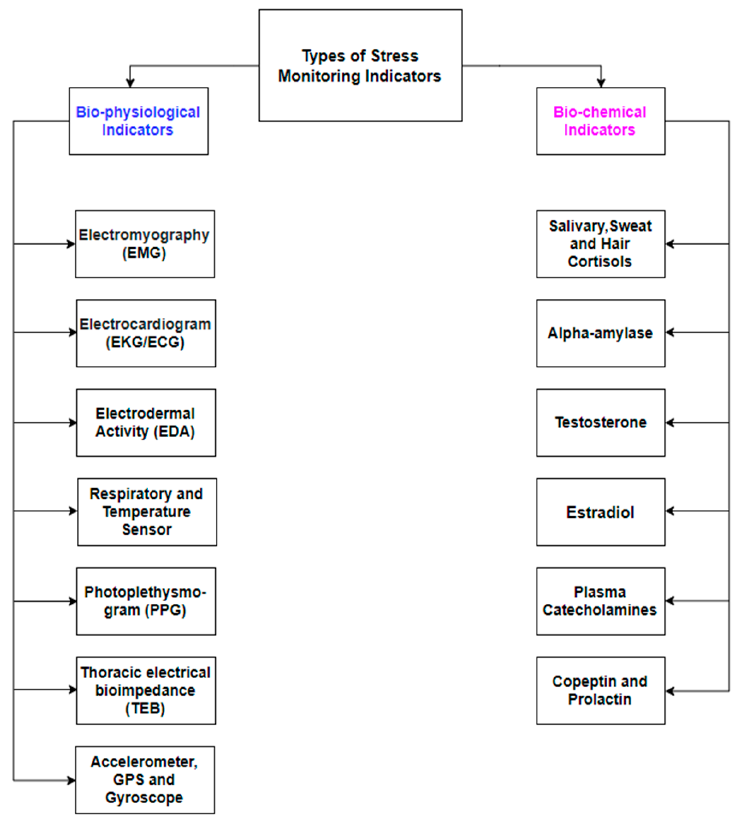
Figure 2. Types of stress indicators: physiological ( left column ) and biochemical ( right column ).